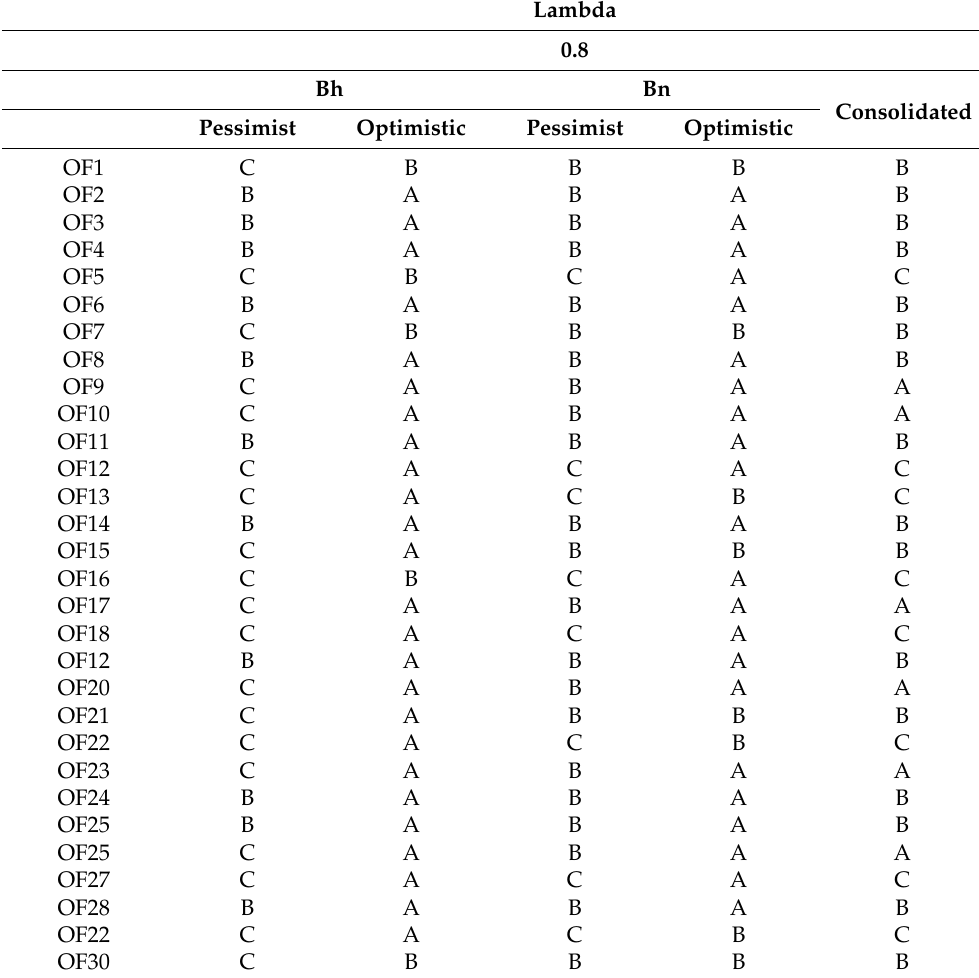
Table 11. Result obtained after application of